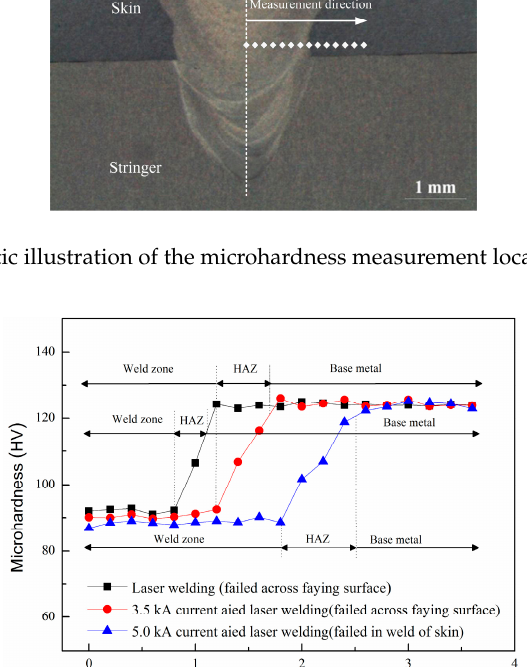
Figure 14. Microhardness distribution for different welded T-joints.